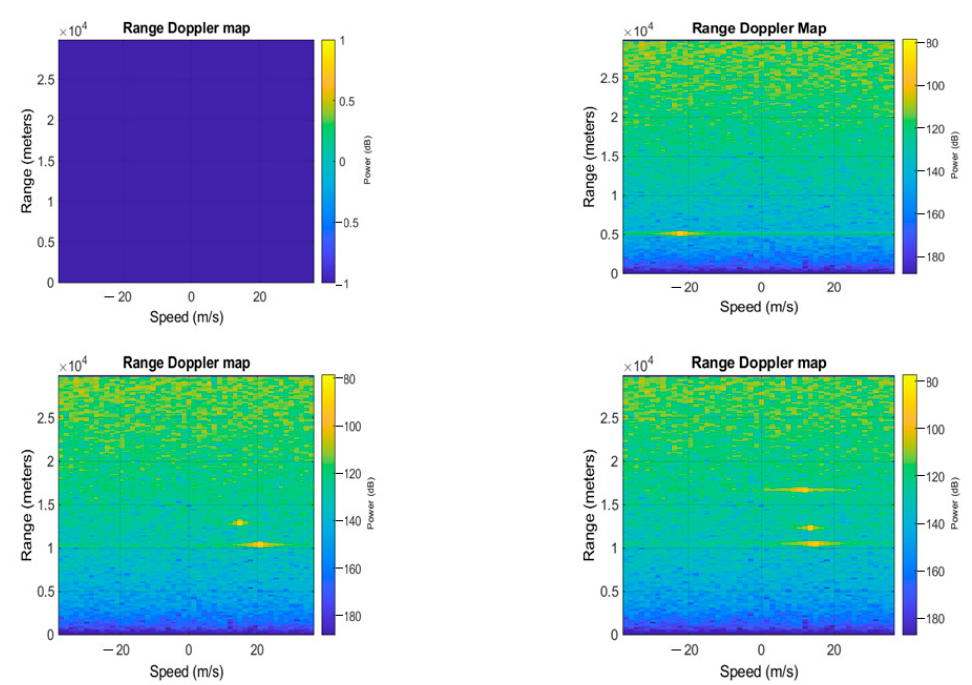
Figure 5. Example of range-Doppler maps generated with (respectively, from the upper left image to the lower right image) 0, 1, 2, 3 targets.